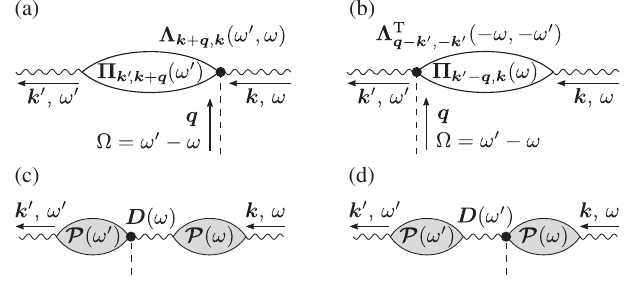
FIG. 9. (a),(b) Diagrammatic representation for the optome- chanical interaction of light (wavy line), medium polarization (bubble), and mechanical vibration (dashed line). (c),(d) The contributions to the amplitude of light scattering by a trembling medium that together with contributions shown in Figs. 2(b) and 2(c) give the full amplitude of inelastic light scattering. Wavy line denotes photon and corresponds to the Green ’ s function for vector potential D ð k ; ω Þ¼ − 4 π ð 1 − k ⊗ k = ω 2 Þ = ð ω 2 − k 2 Þ , empty and filled bubbles correspond to the bare and dressed polarization operators of the medium at rest, Π and P ¼ Π ð 1 − D Π Þ − 1 , respectively, dashed line represents mechanical displacement u q , solid dot is the optomechanical interaction Λ given by Eq.